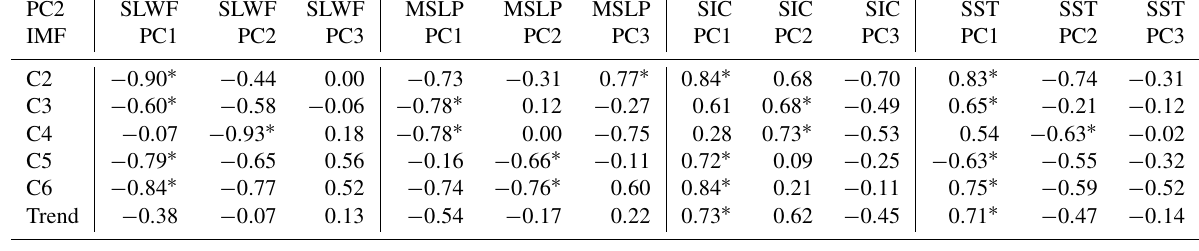
Table 3. The correlations between the second EOF sea ice drift pattern on various timescales and environmental factors (the PCs with the highest correlation values greater than 0.6 are marked with an asterisk).